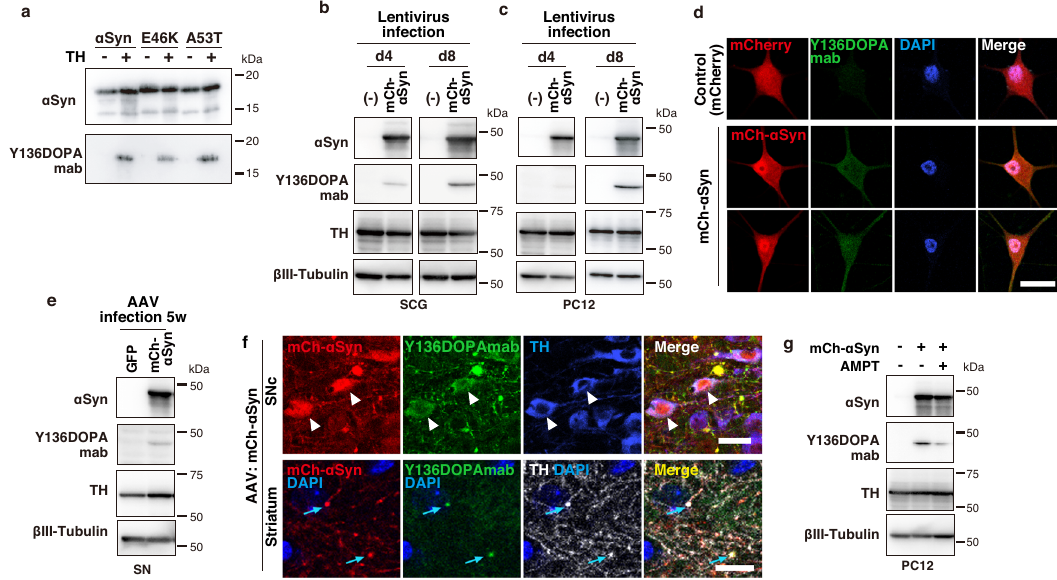
Fig. 2 | Y136DOPA modi fi cation of overexpressed mCh- α Syn detected by a speci fi c antibody. a A speci fi c antibody for Y136DOPA of α Syn. Y136DOPAmab speci fi cally recognized TH-treated (TH+) but not control (TH-) α Syn, E46K, and A53T in WB analysis. b , c Y136DOPA signals detected in cultured SCG neurons ( b ) and PC12 cells ( c ). SCG and PC12 cells overexpressing mCh- α Syn by the lentivirus systemwereharvestedatDay(d)4or8afterinfectionandcontinuouslyexamined byWB.TheY136DOPAsignalwasslightlydetectedatd4butsigni fi cantlyincreased at d8. β III-tubulin is a loading control. d Immuno fl uorescence of PC12 cells over- expressingmCherry(control,upper)ormCh- α Syn(lower)bythelentivirussystem. The Y136DOPA signal (green) was detected in cells expressing mCh- α Syn (red) at d8 after infection. Scale bar: 20 µ m. e Dopanization of mCh- α Syn in mouse SN